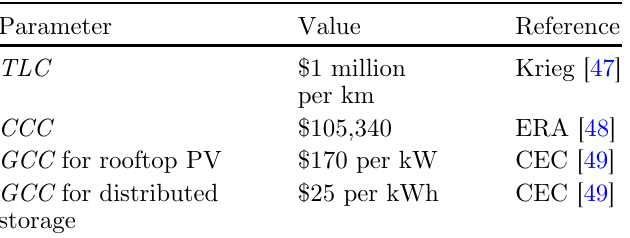
Table 5. New grid costs.